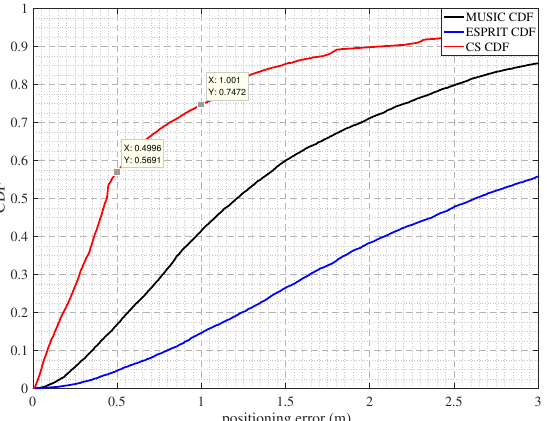
Figure 10. Cumulative distribution function of the positioning errors for the indoor